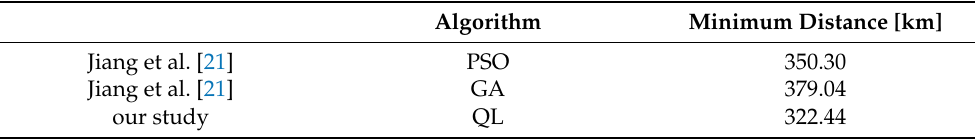
Table 5. Comparison of minimum transportation costs of each method.